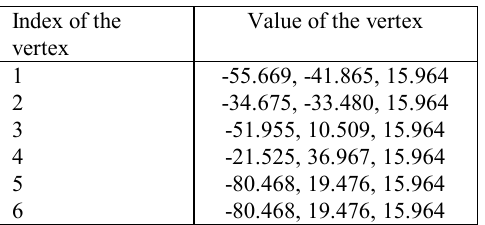
Table 2. Map of the index of each vertex and its 3D value for